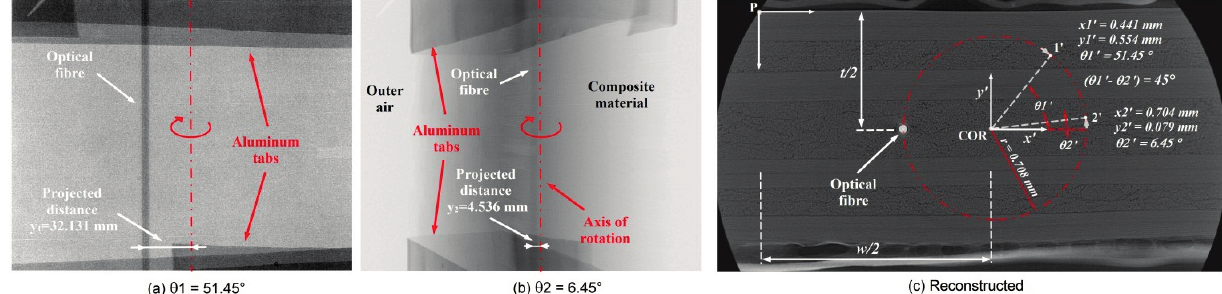
Figure 5. ( a , b ) Two X-ray projections taken at different angles ( i.e. , − 45° and 0°) clockwise with respect to the centre of rotation. The position of the OF is shifting from left to right due to its eccentricity with respect to the rotational axis of the manipulator. The darker regions above and below each projections are aluminium tape stripes attached to the sample; ( c ) Coordinates of the OF for the two different orientations were obtained using the